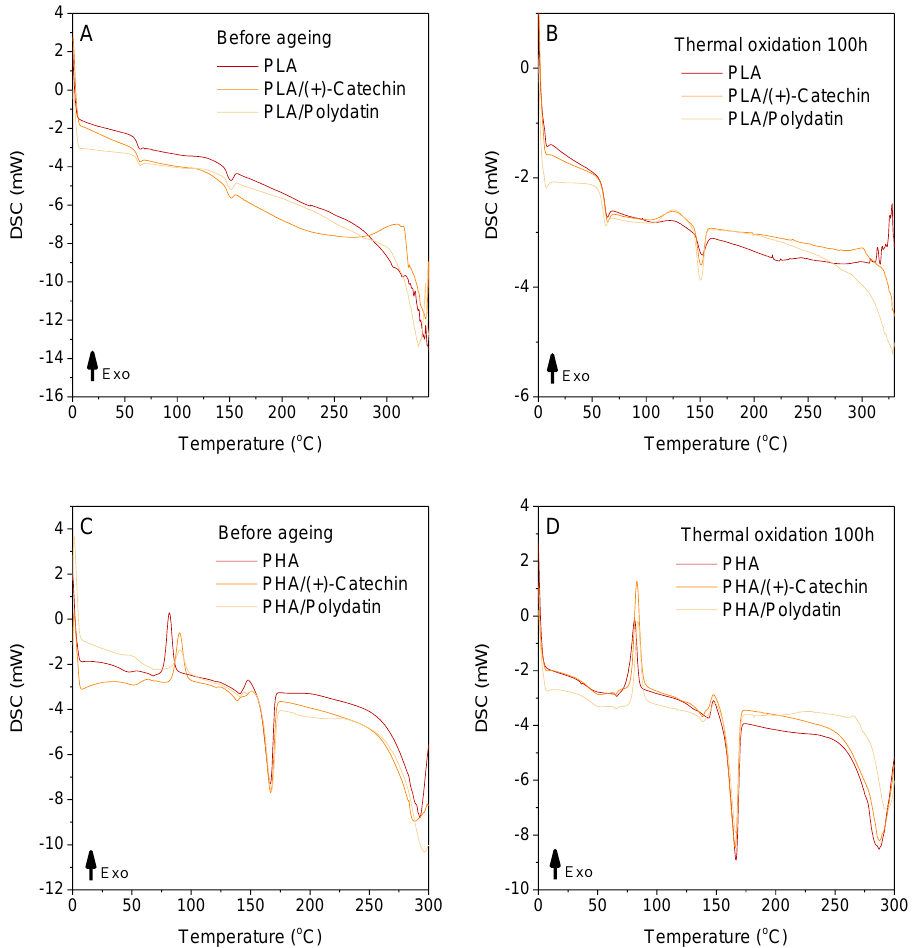
Figure 5. Differential scanning calorimetry (DSC) thermograms of PLA samples before ( A ) and after thermal oxidation aging ( B ), and PHA samples before ( C ) and after thermal oxidation aging ( D ).